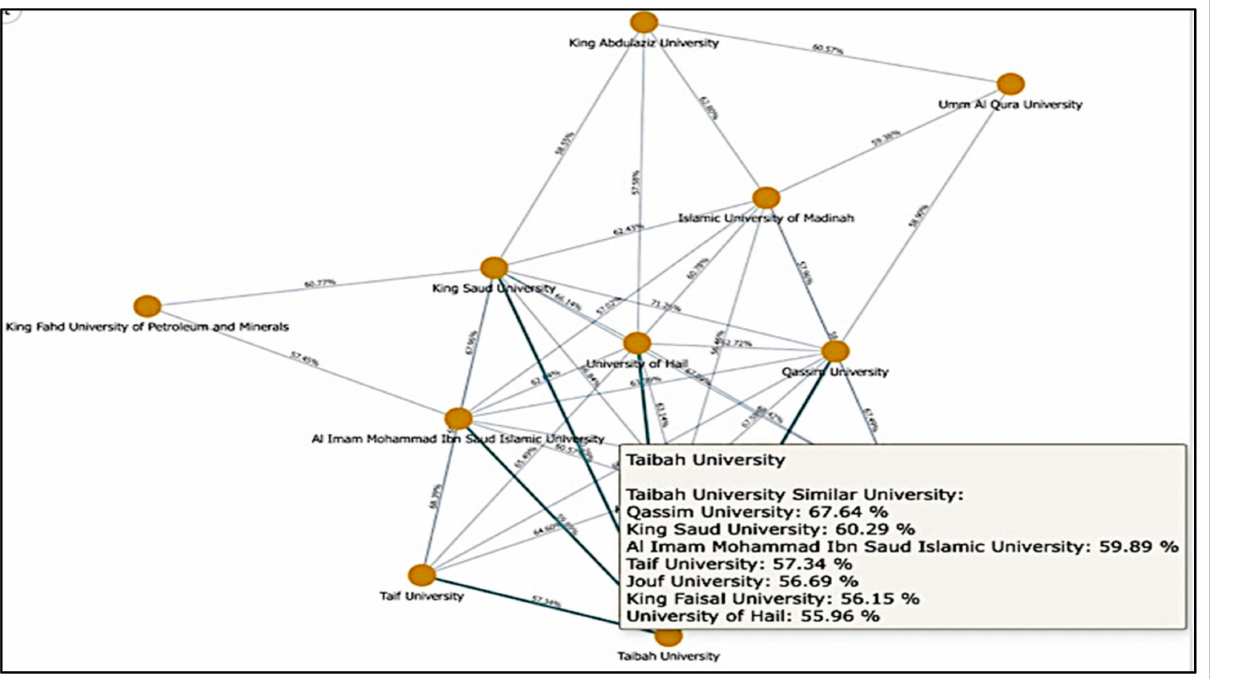
Figure 23. Universities’ interactive co-collaboration network.